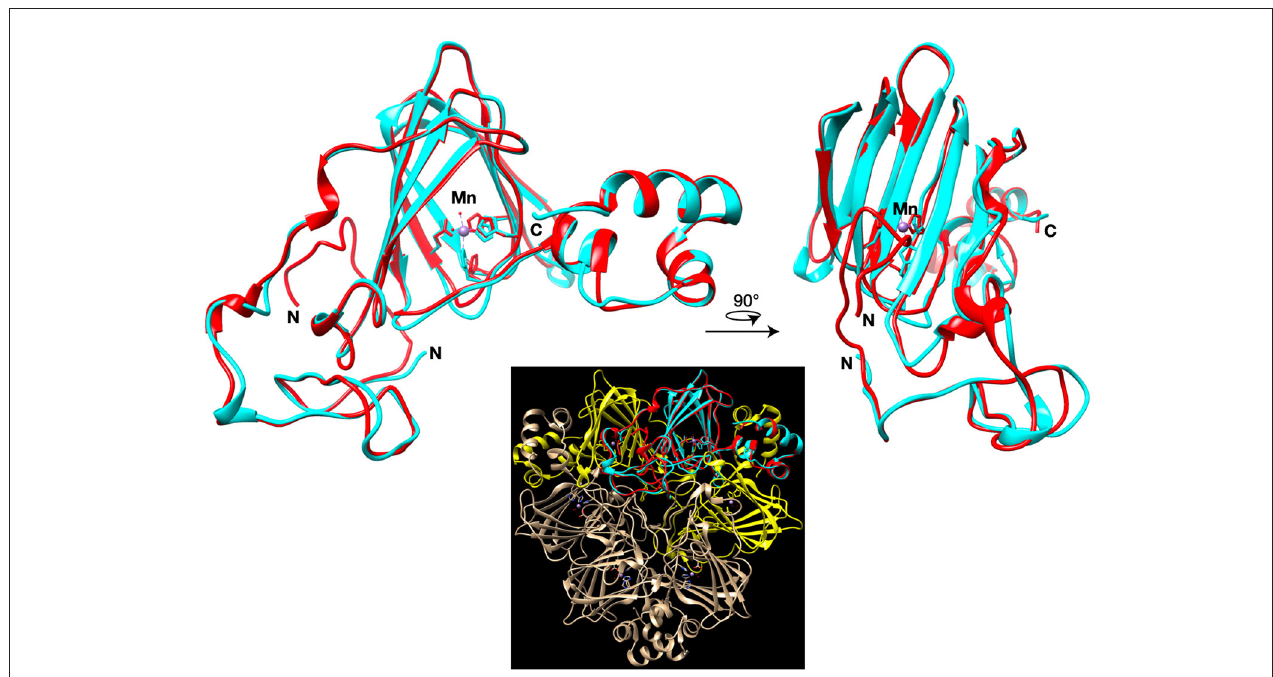
FIGURE 7 | I-TASSER model of the C. quinoa GLP1. Whole quinoa germin-like protein (red) aligned to the template crystal structure of barley germin (oxalate oxidase; pdb:1FI2; cyan). The manganese ion of the active site is shown as a purple sphere. Inset shows the alignment integrated in the hexameric germin structure with neighboring germin monomers colored